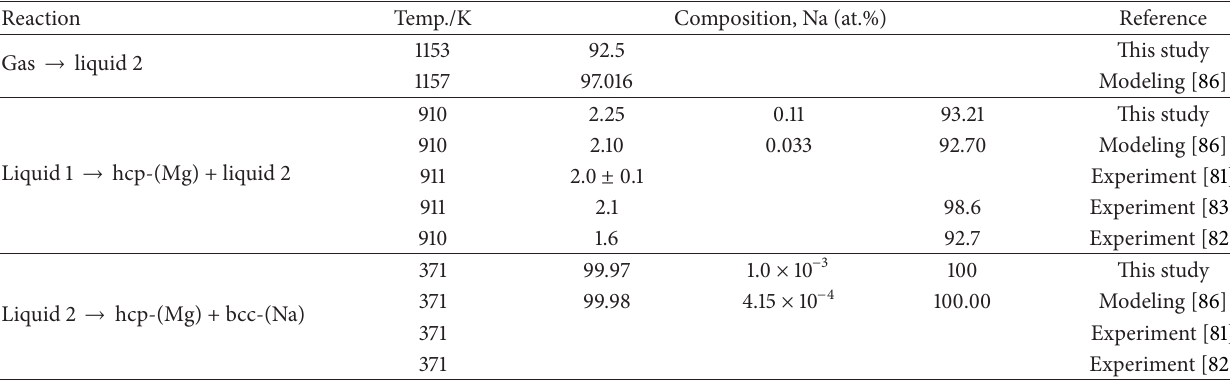
Table 4: Invariant reactions in the Mg-Na system. Reaction Temp./K Composition, Na